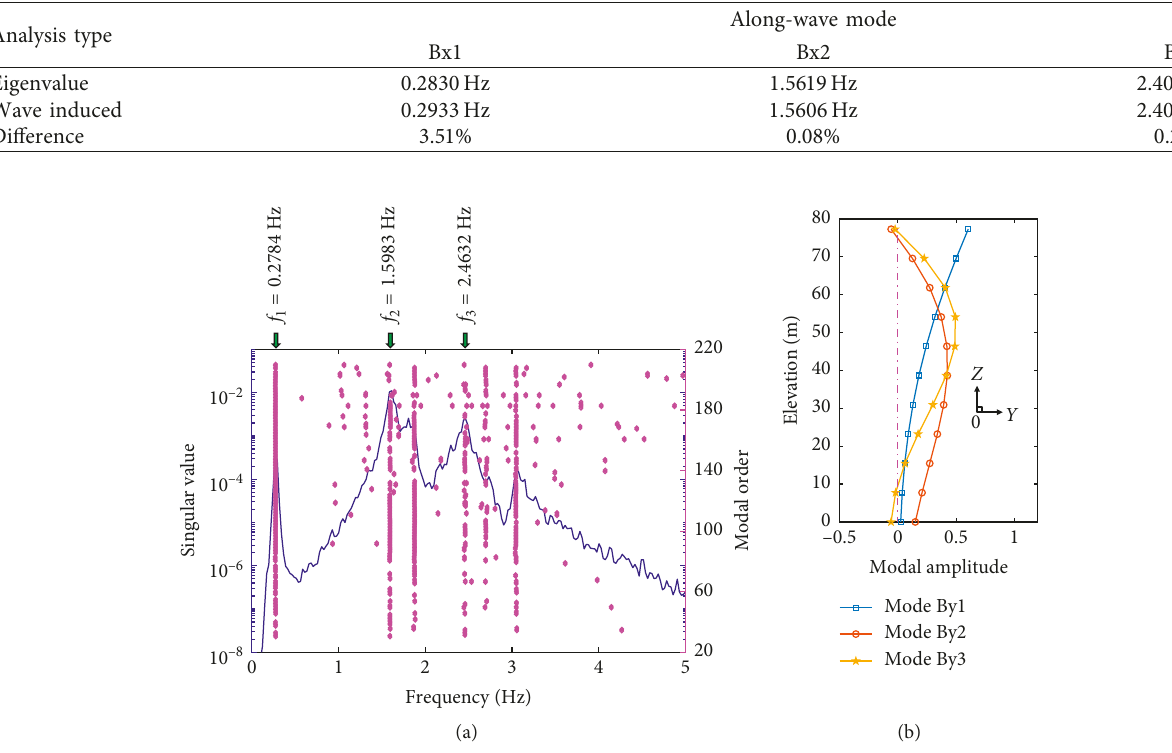
Figure 13: Modal parameter estimation for along-wave bending modes. (a) Singular value chart. (b) Mode shapes. Table 7: Natural frequencies of along-wave bending modes.